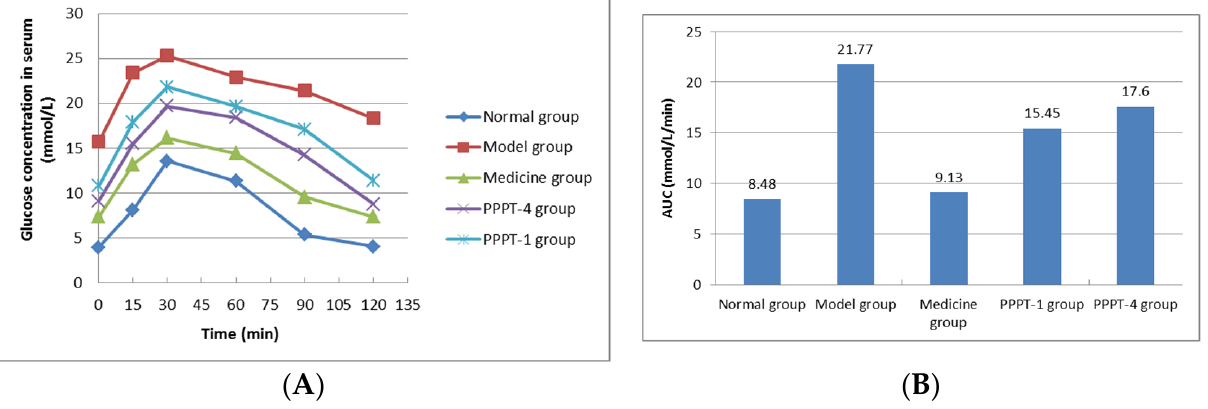
Figure 6. Effect of PPPT on type II diabetic mice. ( A ) Glucose concentration in serum within 120 min; ( B) Area under the curve (AUC).